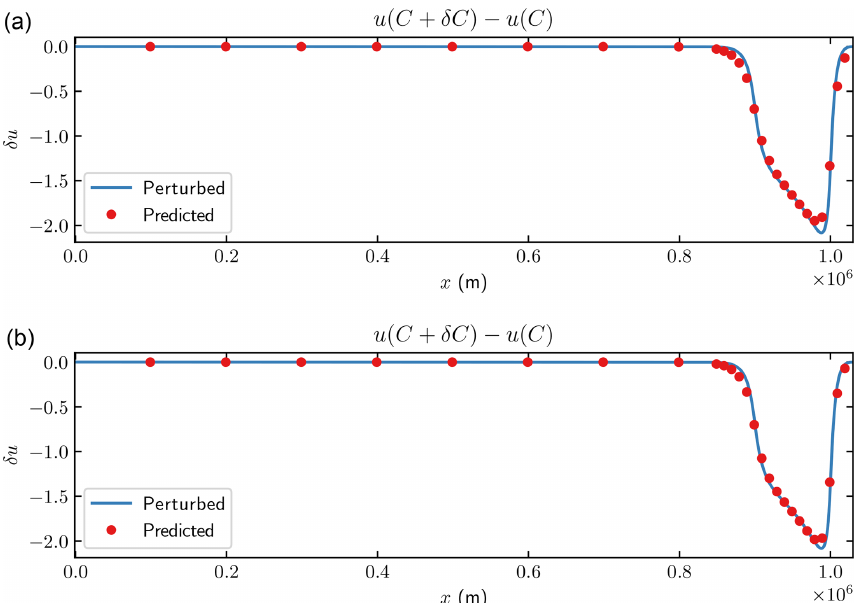
Figure 14. The changes in the horizontal velocity u for SSA after 1 year with 1% perturbation of C(x) in x ∈ [ 0 . 9 , 1 . 0 ]× 10 6 m. Solid lines are the differences between the steady-state and the perturbed solutions in Eq. (13). Red dots represent the estimated perturbation using